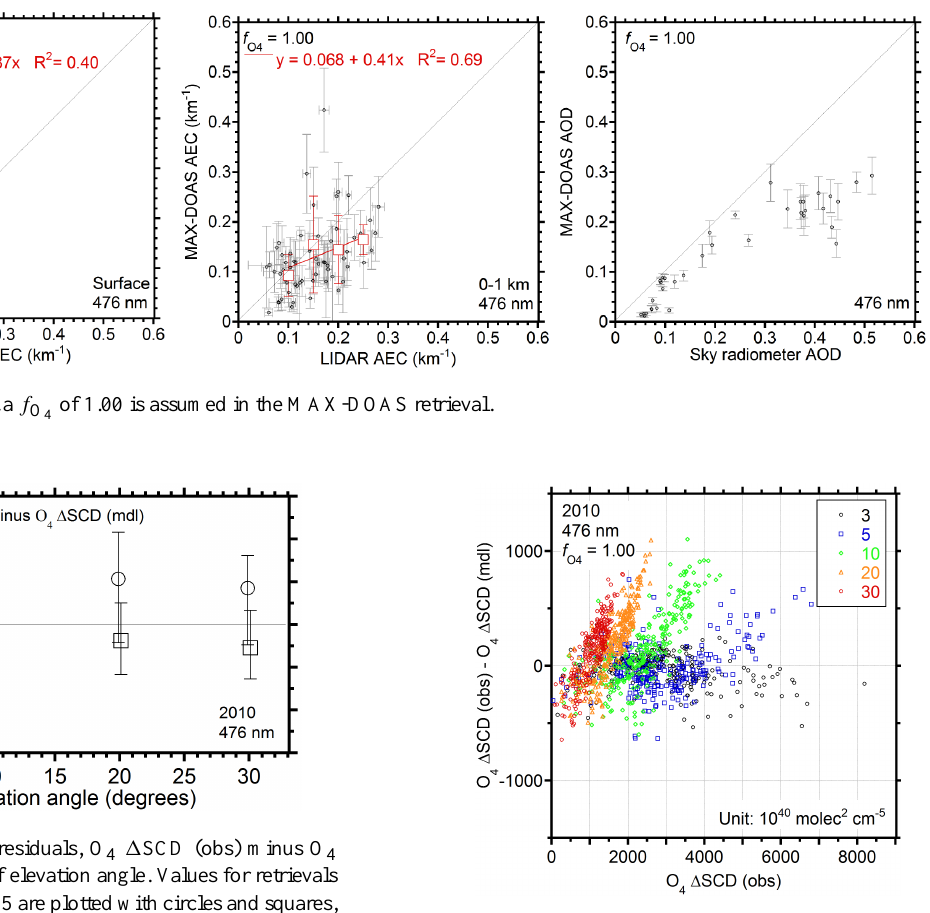
nus O 4 (cid:49) SCD (mdl), as a function of O 4 (cid:49) SCD (obs). Values for retrievals with f O =1.00 are plotted. Values for α of 3, 5, 10, 20, 4 and 30 ◦ are shown in black, blue, green orange, and red, respec-